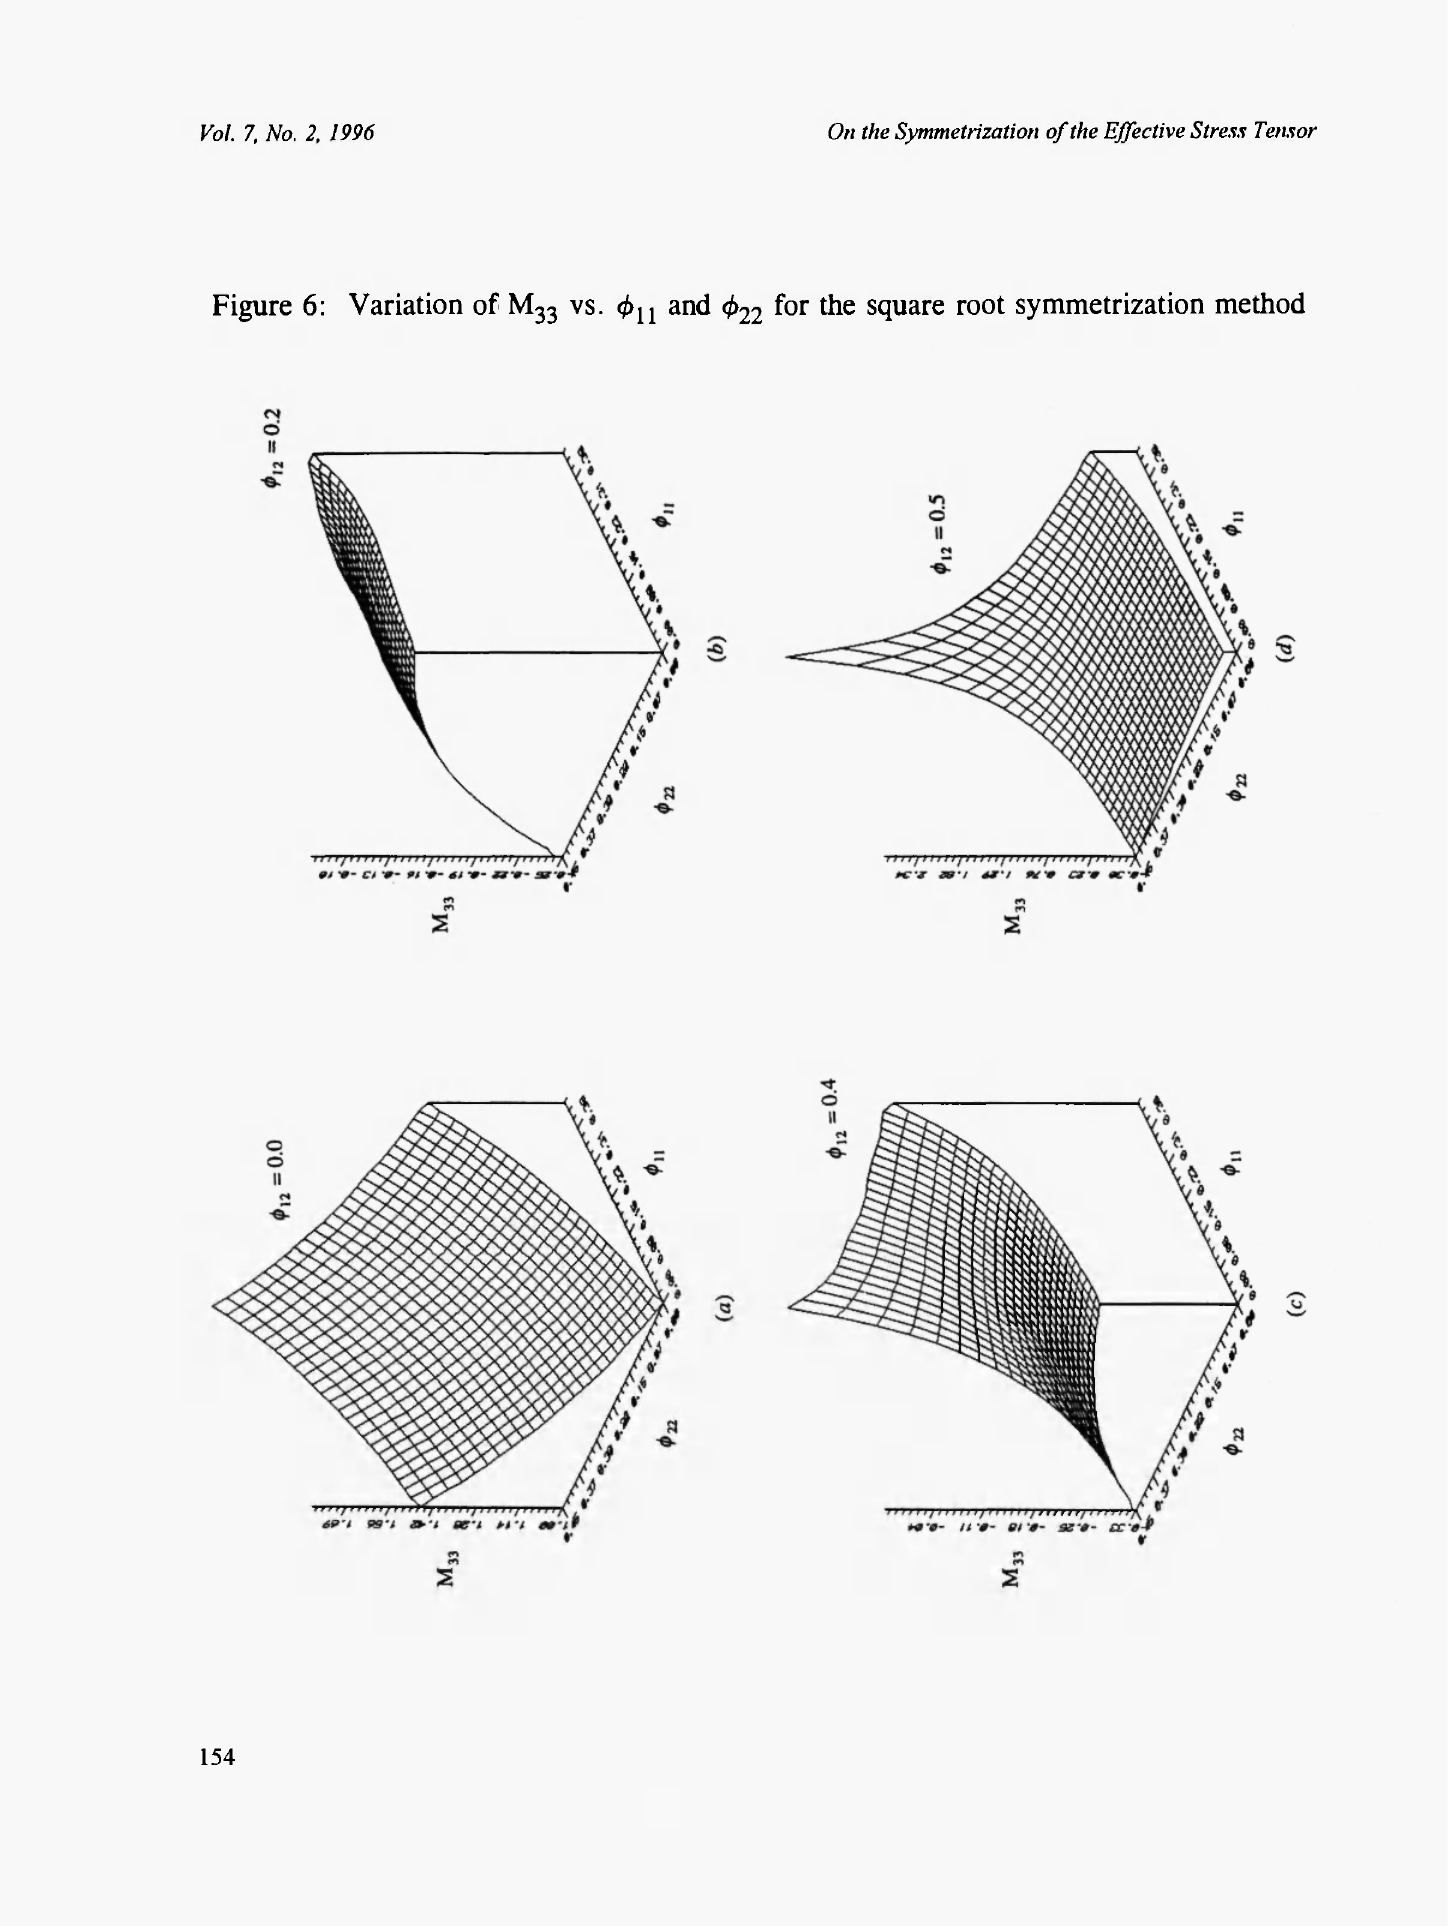
vs. φ and φ for the square root symmetrization 33 η 22